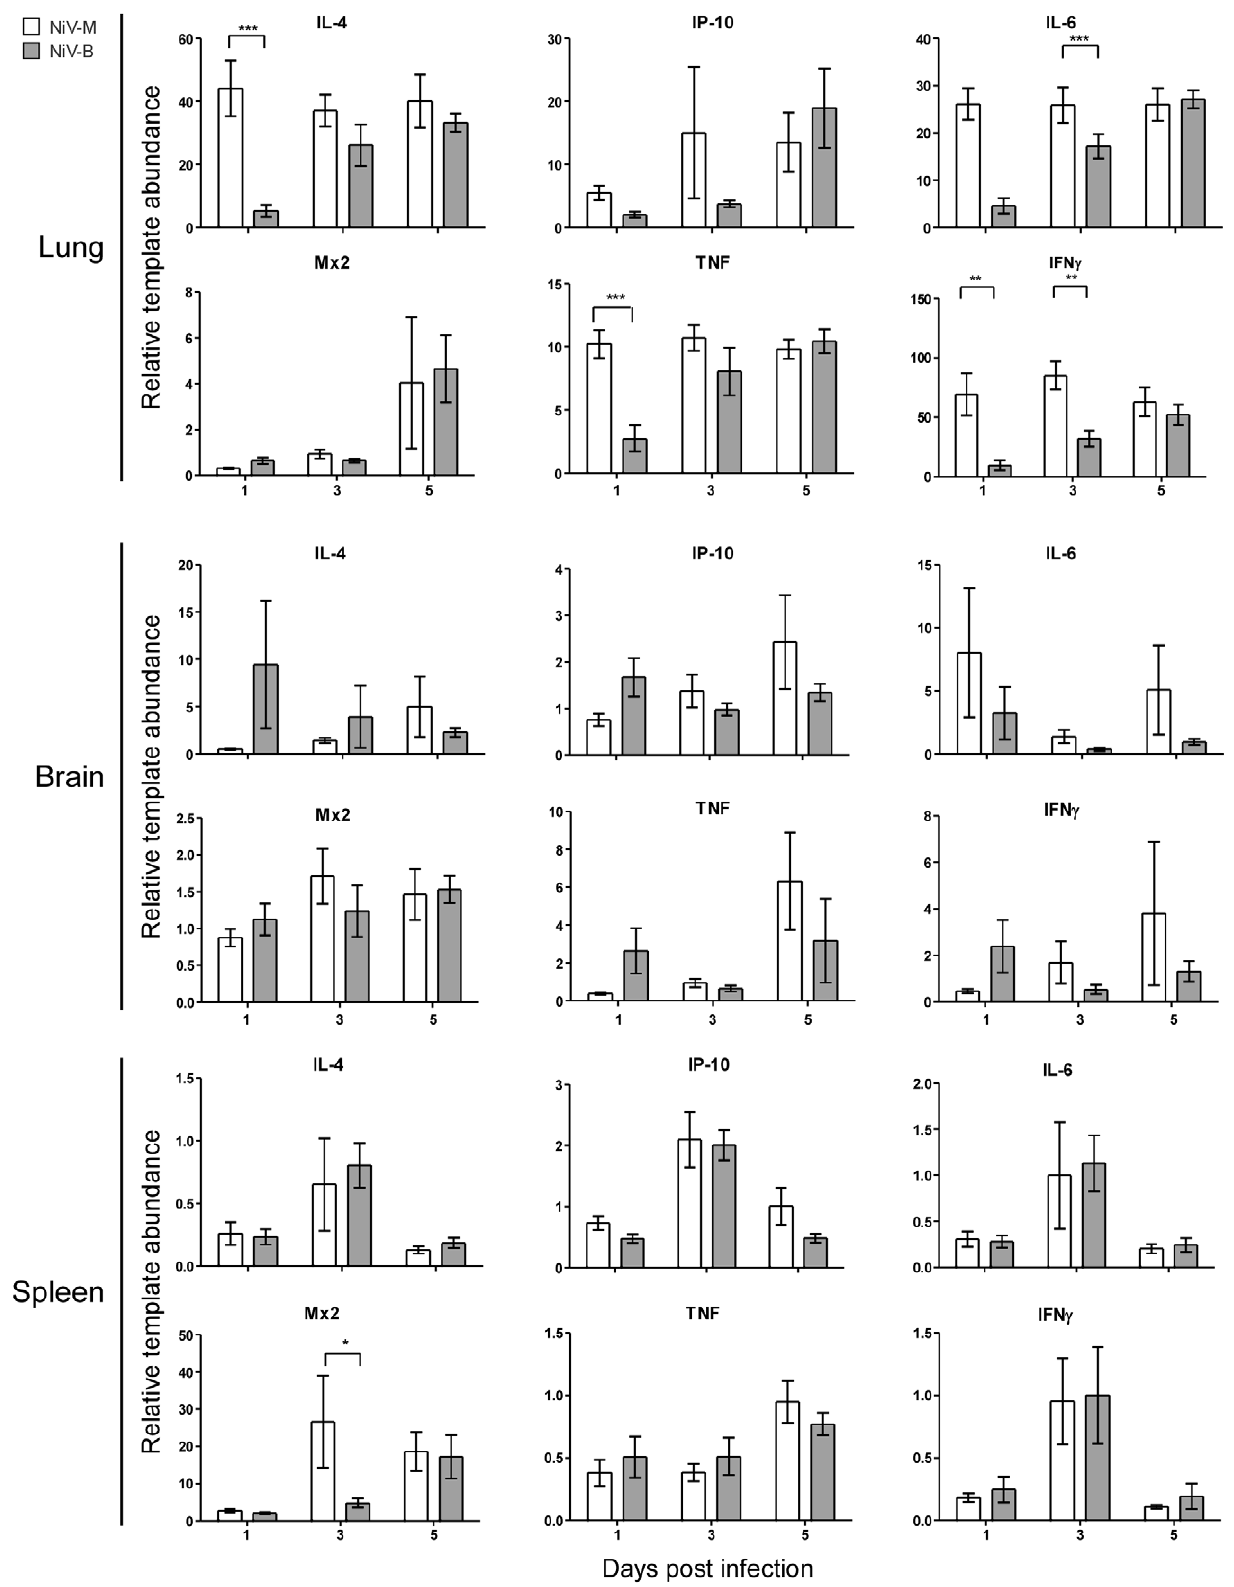
Figure 4. Host gene expression in lung, brain and spleen tissue of hamsters is differentially regulated during infection with Nipah viruses. Quantitative RT-PCR for IL-4, IP-10, IL-6, Mx2, TNF and IFN c was performed on lung, brain and spleen tissues from groups of 9 hamsters inoculated with 10 5 TCID 50 of NiV-M (white bars) or NiV-B (gray bars) at the indicated time points. Data are shown as the fold-change of each gene over uninfected controls and normalized to an internal reference gene (RPL18). Error bars represent the SEM. A 2-way ANOVA with Bonferroni’s post- test was used to determine statistical significance between viruses (*=p , 0.05, **=p , 0.01 and ***=p , 0.001). doi:10.1371/journal.pntd.0002024.g004 PLOS Neglected Tropical Diseases |